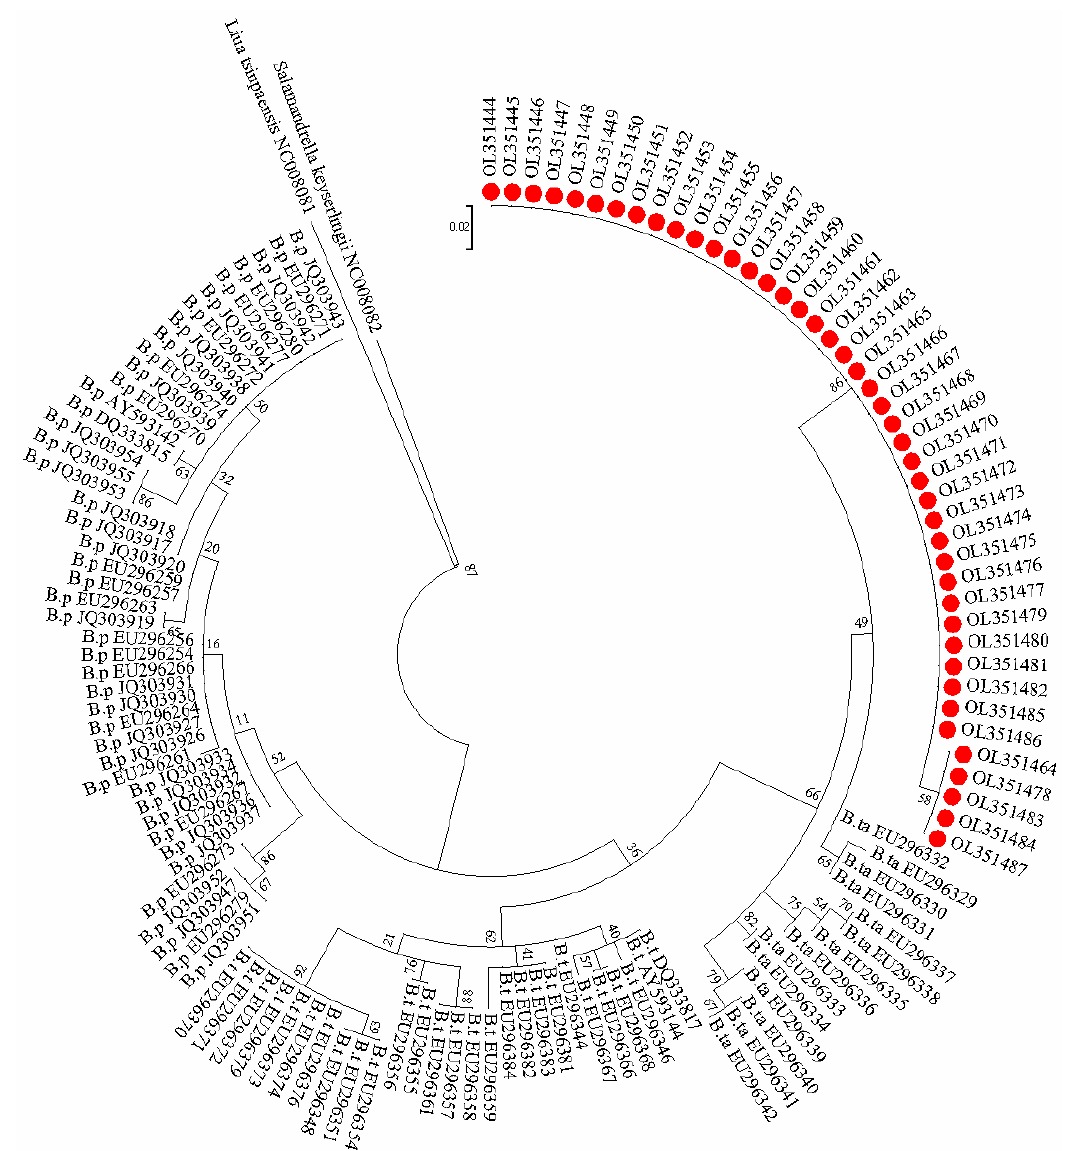
Figure 4. Molecular phylogenetic tree by Maximum Likelihood method (The ML tree is based on the HKY + I + G model; B. p, Batrachuperus pinchonii , B. t, Batrachuperus tibetanus , B. ta, Batrachuperus taibaiensis ; red circles show the sample sequences from this study; Liua tsinpaensis and Salamandrella keyserlingii as an outgroup; numbers on branch in the tree are bootstrap values with percentage.).